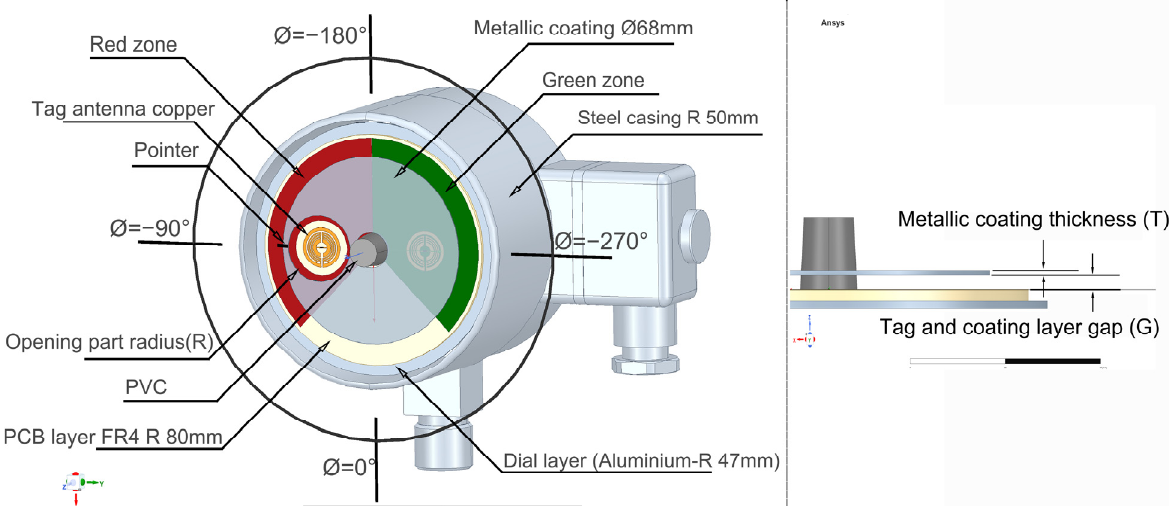
Figure 4. Digitized manometer components and materials.